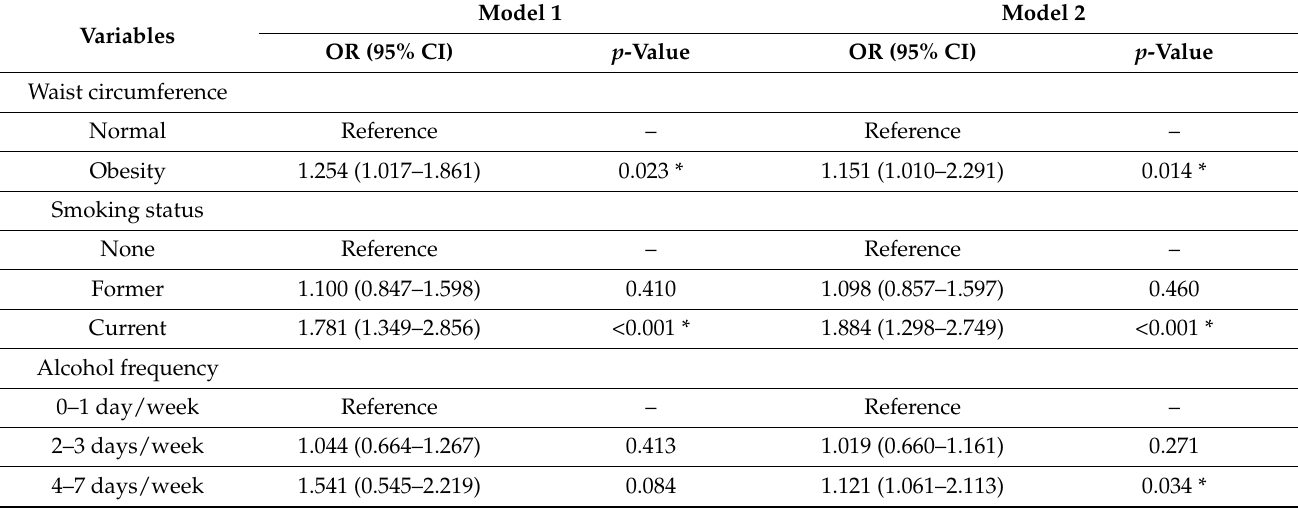
Table 3. Prevalence of colorectal polyp in men based on health